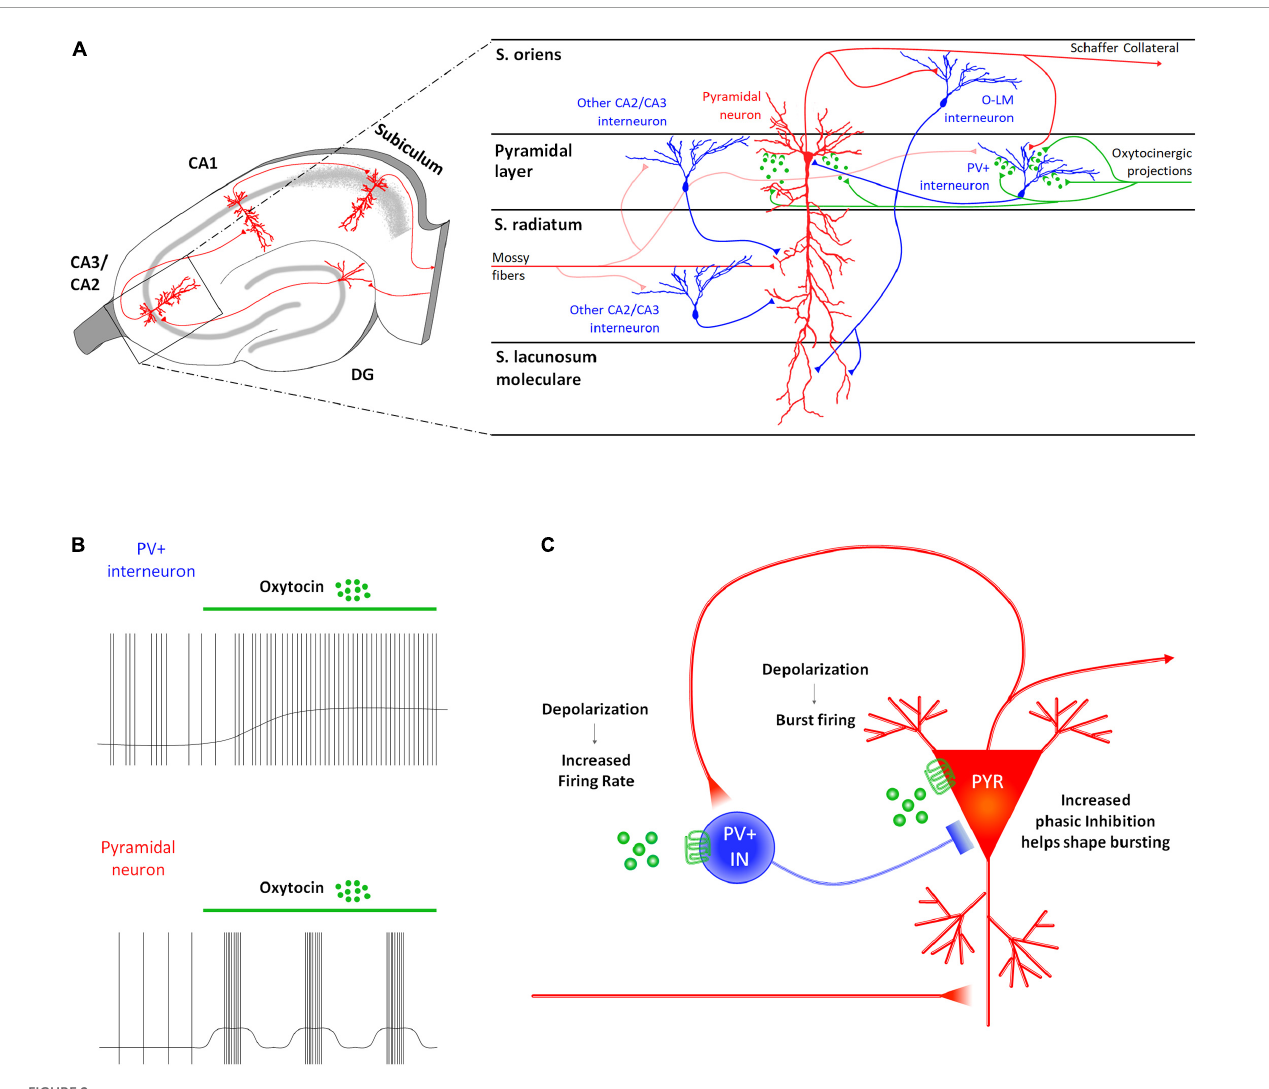
FIGURE2 Receptor distribution, oxytocinergic projections and main effects exerted by oxytocin (OT) at CA2/CA3 (DG) region of the rodent’s hippocampus. (A) At the CA2/CA3 region, OTRs are found both on the projective glutamatergic pyramidal neurons (PYR–red) and on parvalbumin positive GABAergic interneurons (PV + INs–blue). (B) In this region, OT increases the PV + IN excitability by depolarizing their membrane potential and by increasing their firing rate. Also, it exerts an excitatory effect on the PYRs by depolarizing their membrane and by promoting the onset of a bursting firing pattern. (C) In CA2/CA3, OT induces a reciprocal modulation of the neuronal activity of PYRs and PV + INs. Specifically, the OT-dependent increased excitability of the PYRs reverberates on the PV + IN by increasing frequency and amplitude of the EPSPs onto the PV + IN receiving Schaffer’s collaterals. In turn, OT-dependent increased excitability of PV + IN supports a GABAergic input onto the PYR that modulates their burst firing and appears to be essential in promoting reliability of synaptic communication in the downstream areas of the